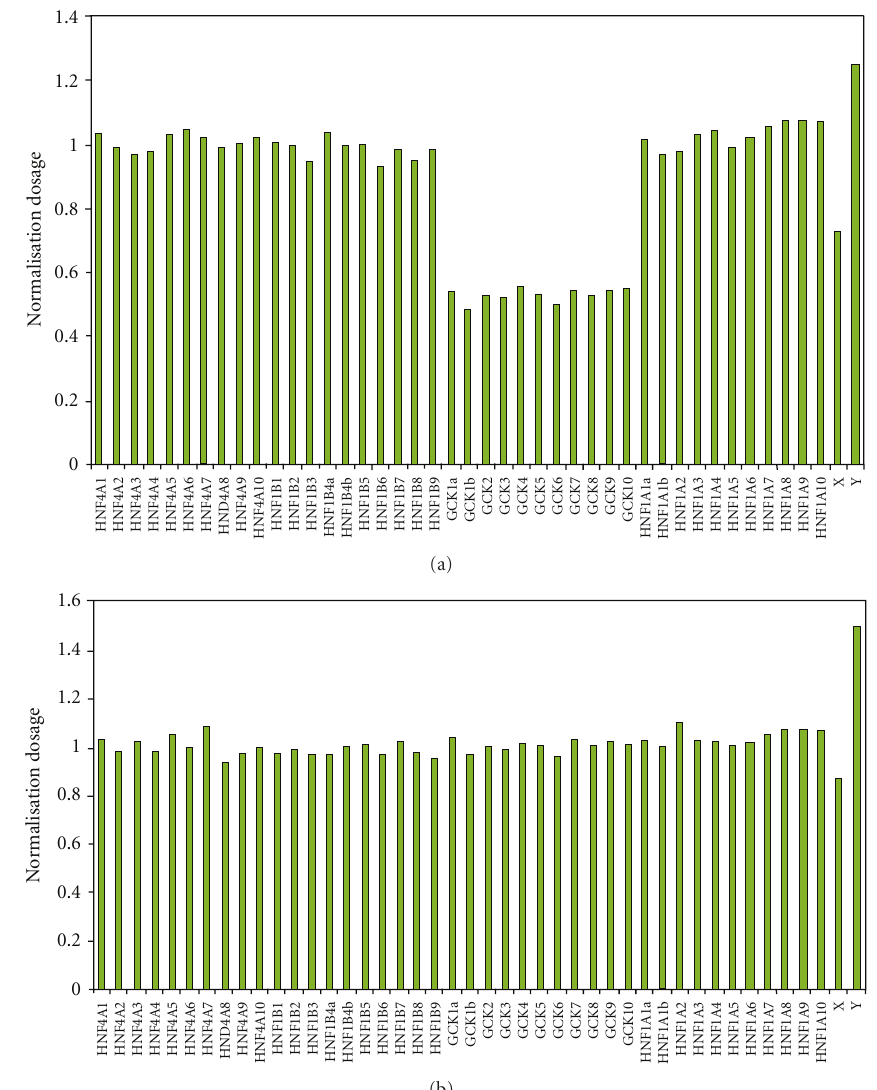
(b) Figure 2: Detection of a whole GCK gene deletion (MODY2) by multiplex ligation-dependent amplification dosage assay (MLPA). Graphical representation of HNF4A (MODY1) , HNF1A (MODY3) , HNF1B (MODY5) , GCK (MODY2), Chromosome X, and Y probes normalised to controls in the proband (a) and one of the examined family members (b). All GCK probes are expressed in half dosage in the proband indicating a total GCK